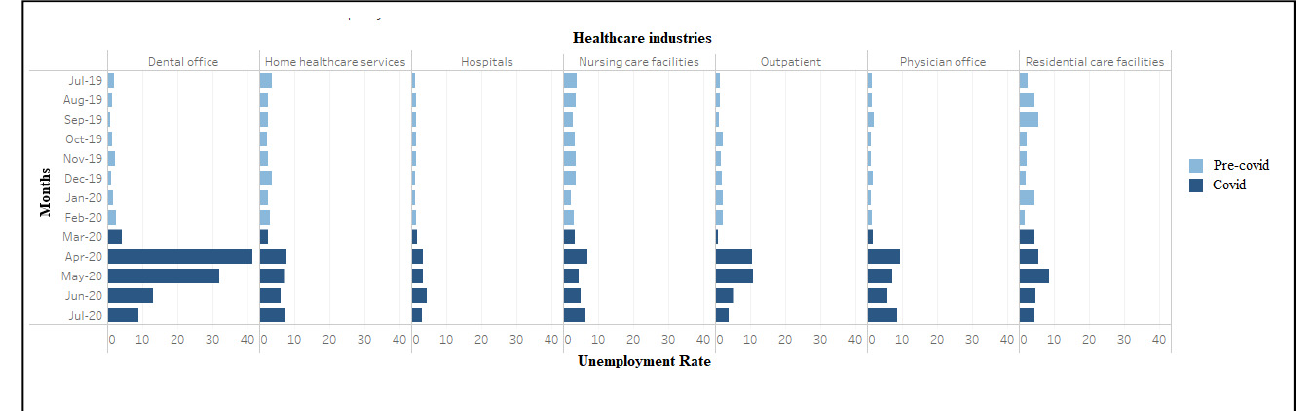
Figure 1. Unemployment rate (weighted) among workers in healthcare industries (July 2019–2020).